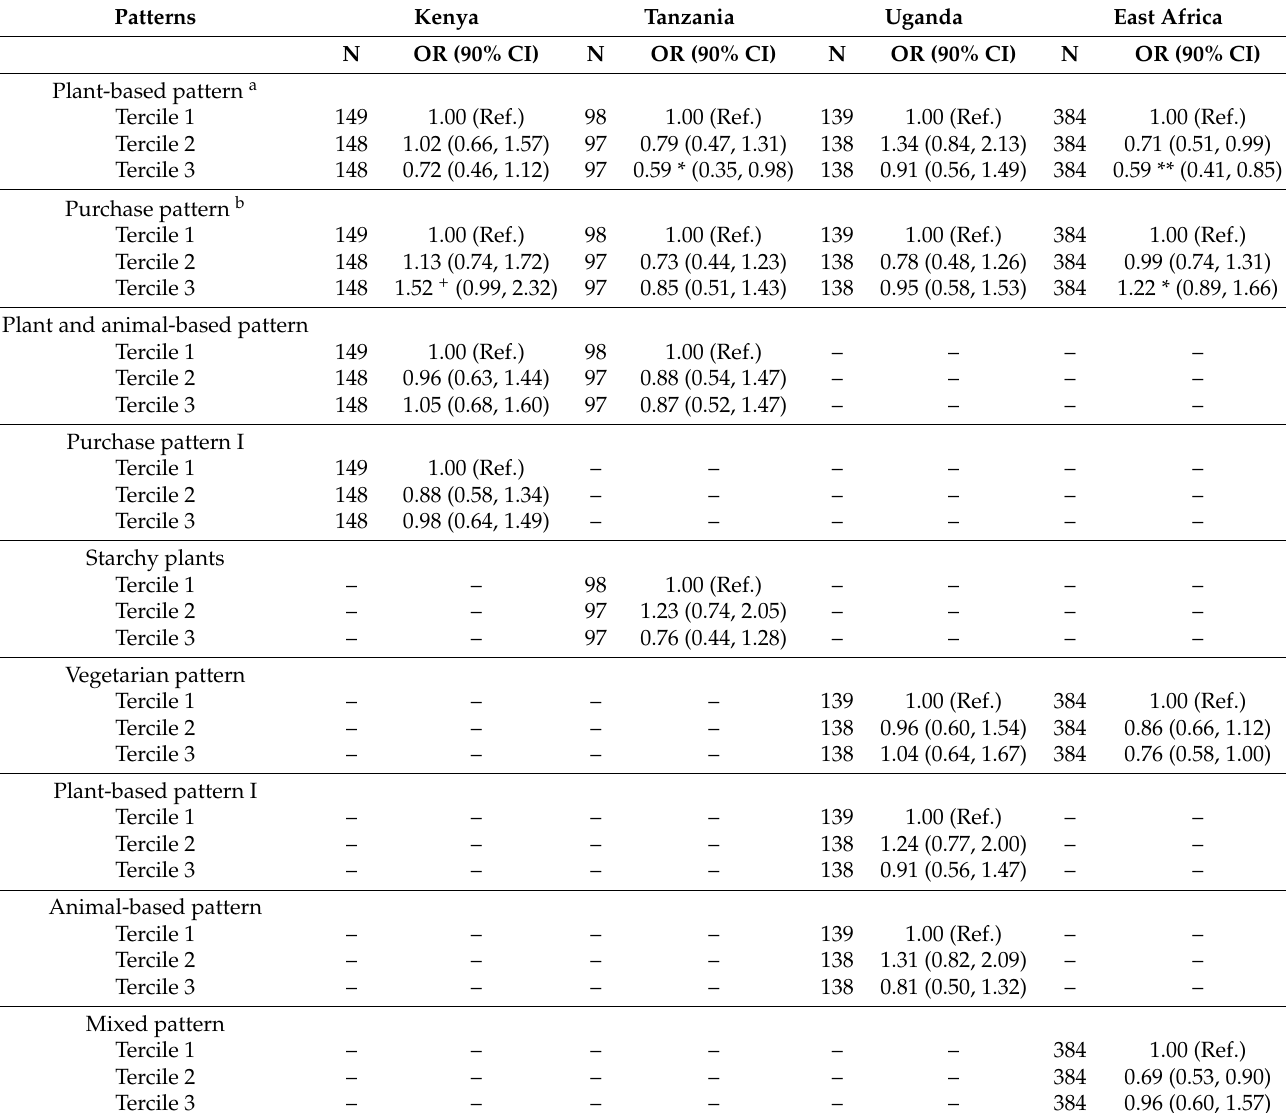
Table 7. Association between patterns extracted (in terciles) and overweight and obesity among rural women of reproductive age in Kenya, Tanzania, Uganda, and East